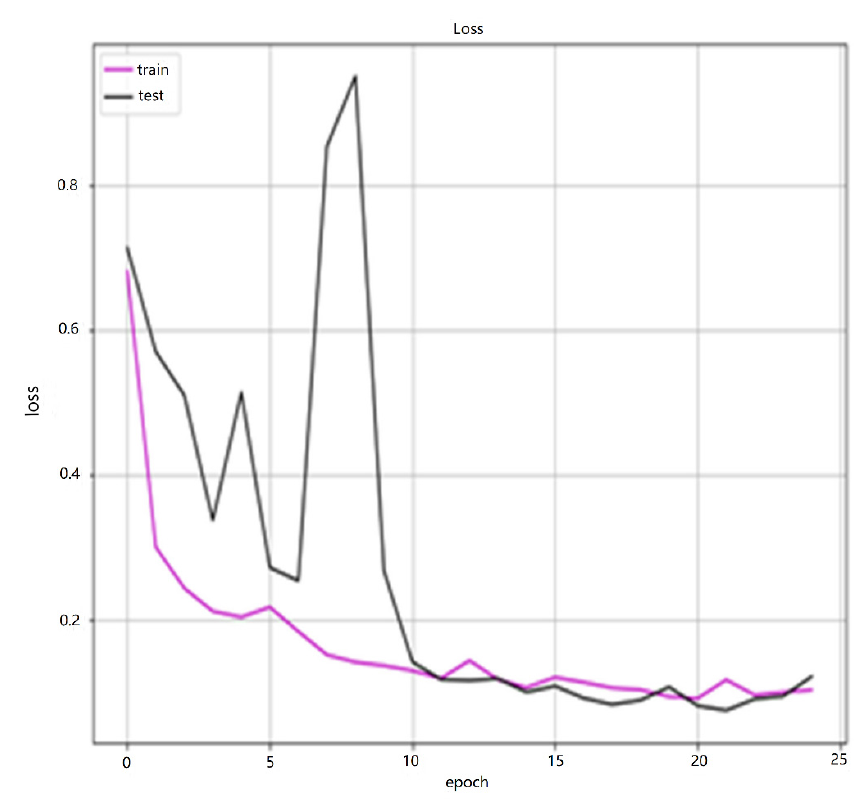
Figure 11. Classification model’s loss curve.